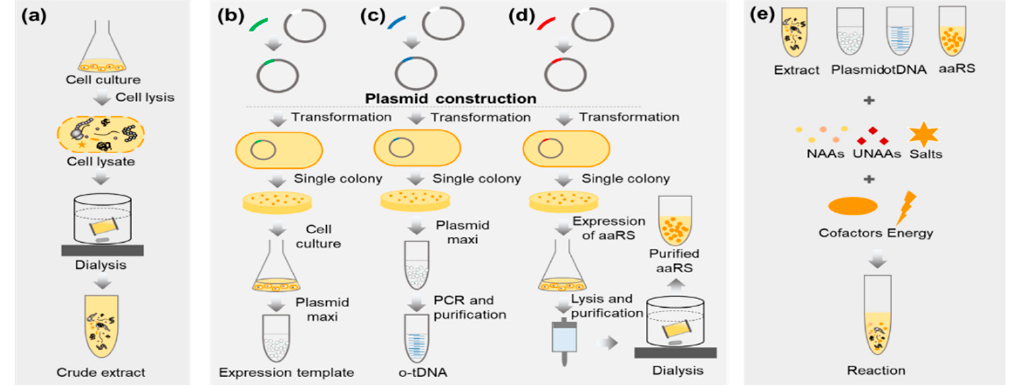
Figure 1. Experimental design. ( a ) Preparation of crude extract; ( b ) extraction of expression templates; ( c ) purification of o-tDNA; ( d ) purification of aaRS; ( e ) cell-free protein synthesis reaction.